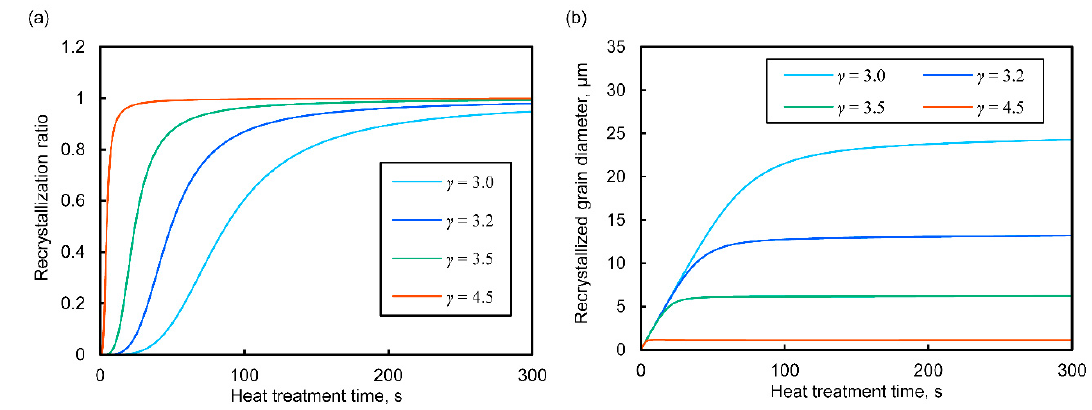
Figure 16. Variation of ( a ) recrystallization ratio and ( b ) recrystallized grain size with respect to applied shear strain by cutting during heat treatment at 600 °C.